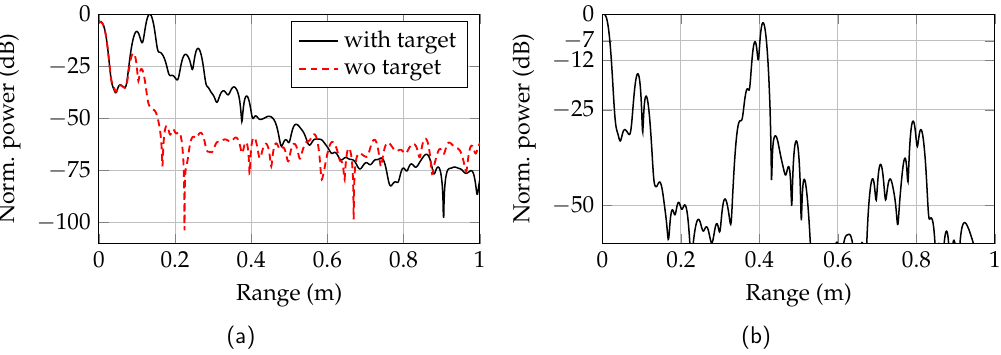
Figure 12. Range spectra of the RTG for the minimum measurable distance ( a ) and with two targets in a distance of 1.5cm from each other ( b ).